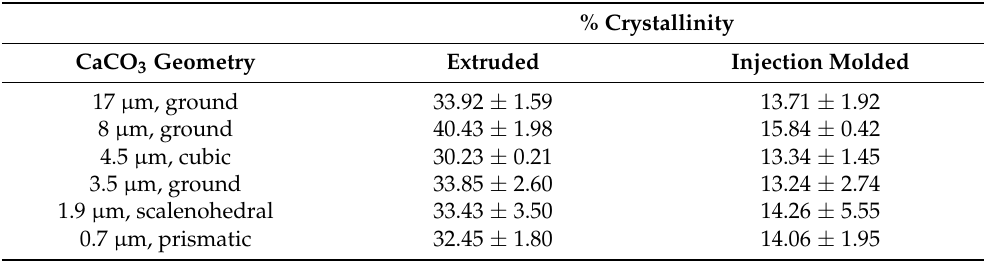
Table 3. Crystallinity content as determined by DSC. Values indicate an average of 3 repetitions and ± indicate 1 standard deviation to measure variation.